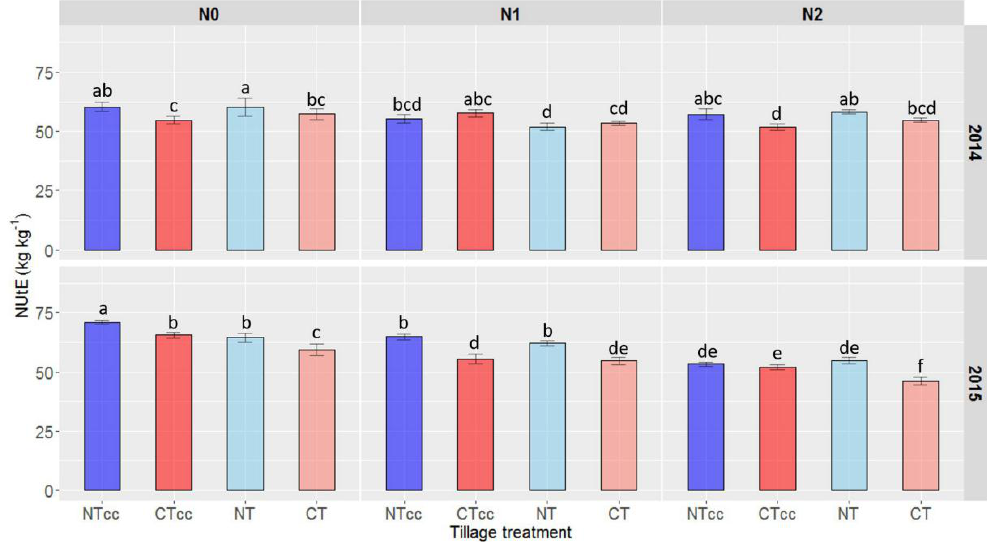
Figure 2. Impact of soil tillage treatment, cover crops and N application on NUtE of wheat grown in 2014 and 2015. NTcc: No-till with cover crops. NT: No-till without cover crops. CTcc: Conventional tillage with cover crops. CT: Conventional tillage without cover crops. N0: no added N fertilization. N1: 161 kg N ha −1 . N2: 215 kg N ha −1 . Soil tillage practices (CT and NT) and N fertilization (N0, N1 and N2) were subjected to analysis of variance (two-way ANOVA, with tillage practice with or without cc and N fertilization as the two main parameters). Treatment means were compared using Duncan's new multiple range test at a 95% family-wise confidence level. Means with the same letter are not significantly different across N fertilizer